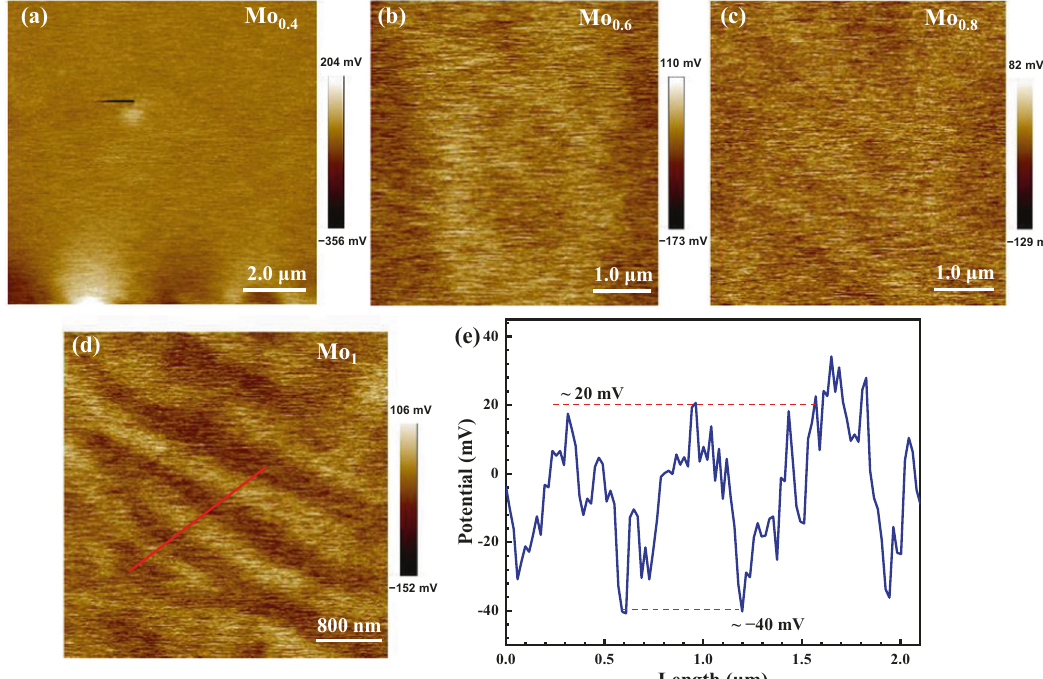
Fig. 7 SKPFM results of CoCrFeNiMo x HEAs. Surface voltage potential maps of ( a ) Mo 0.4 , ( b ) Mo 0.6 , ( c ) Mo 0.8 , ( d ) Mo 1 , ( e ) corresponding line- pro fi le analysis of relative Volta potential in map ( d